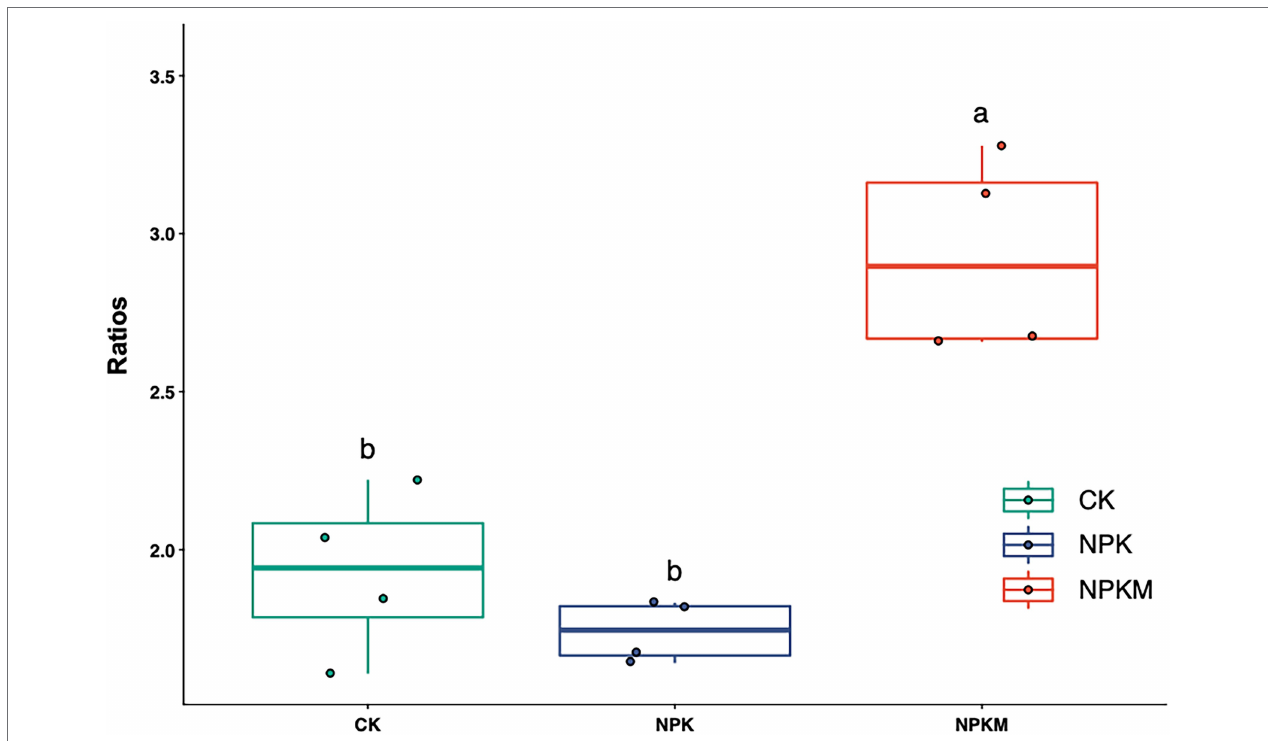
FIGURE 7 | Effects of long-term fertilization treatments on the ratio of Proteobacteria to Acidobacteria . Different letters indicate significant differences (Tukey’s post hoc test, p <